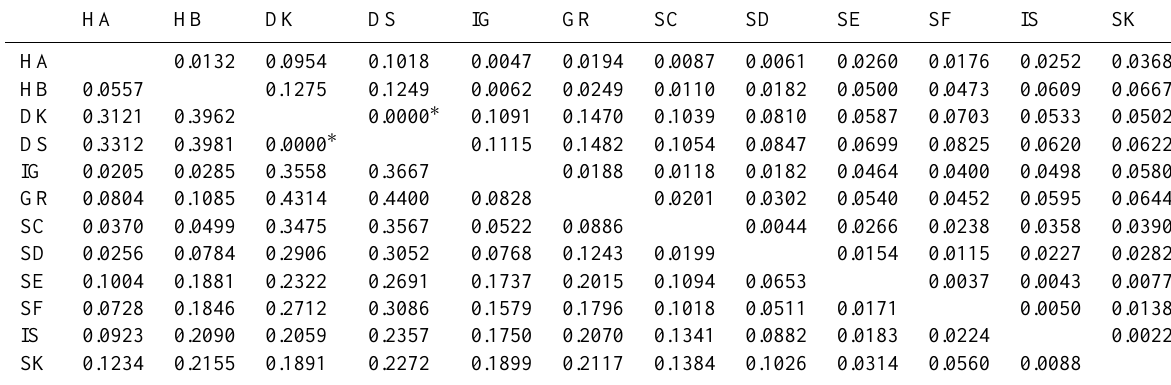
Table 4. Nei’s genetic distances are displayed on the upper diagonal and F ST values on lower diagonal ( ∗ non-significant values). HA HB DK